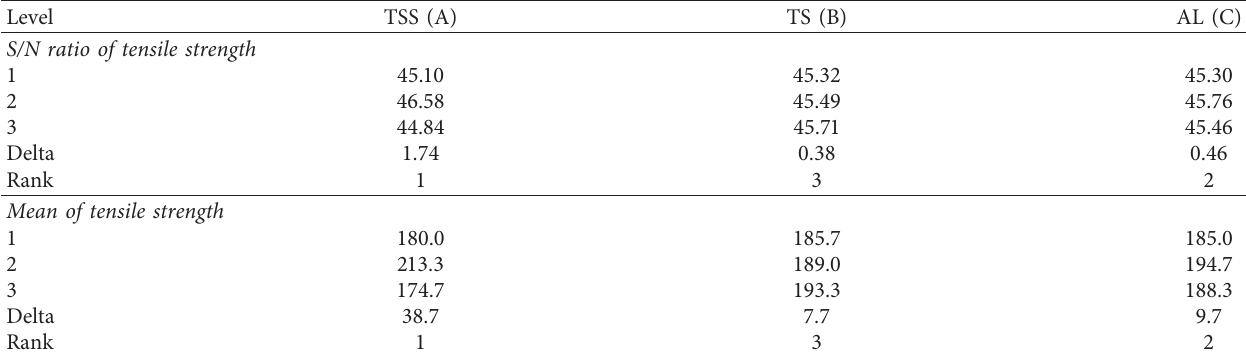
Table 5: Response table for tensile